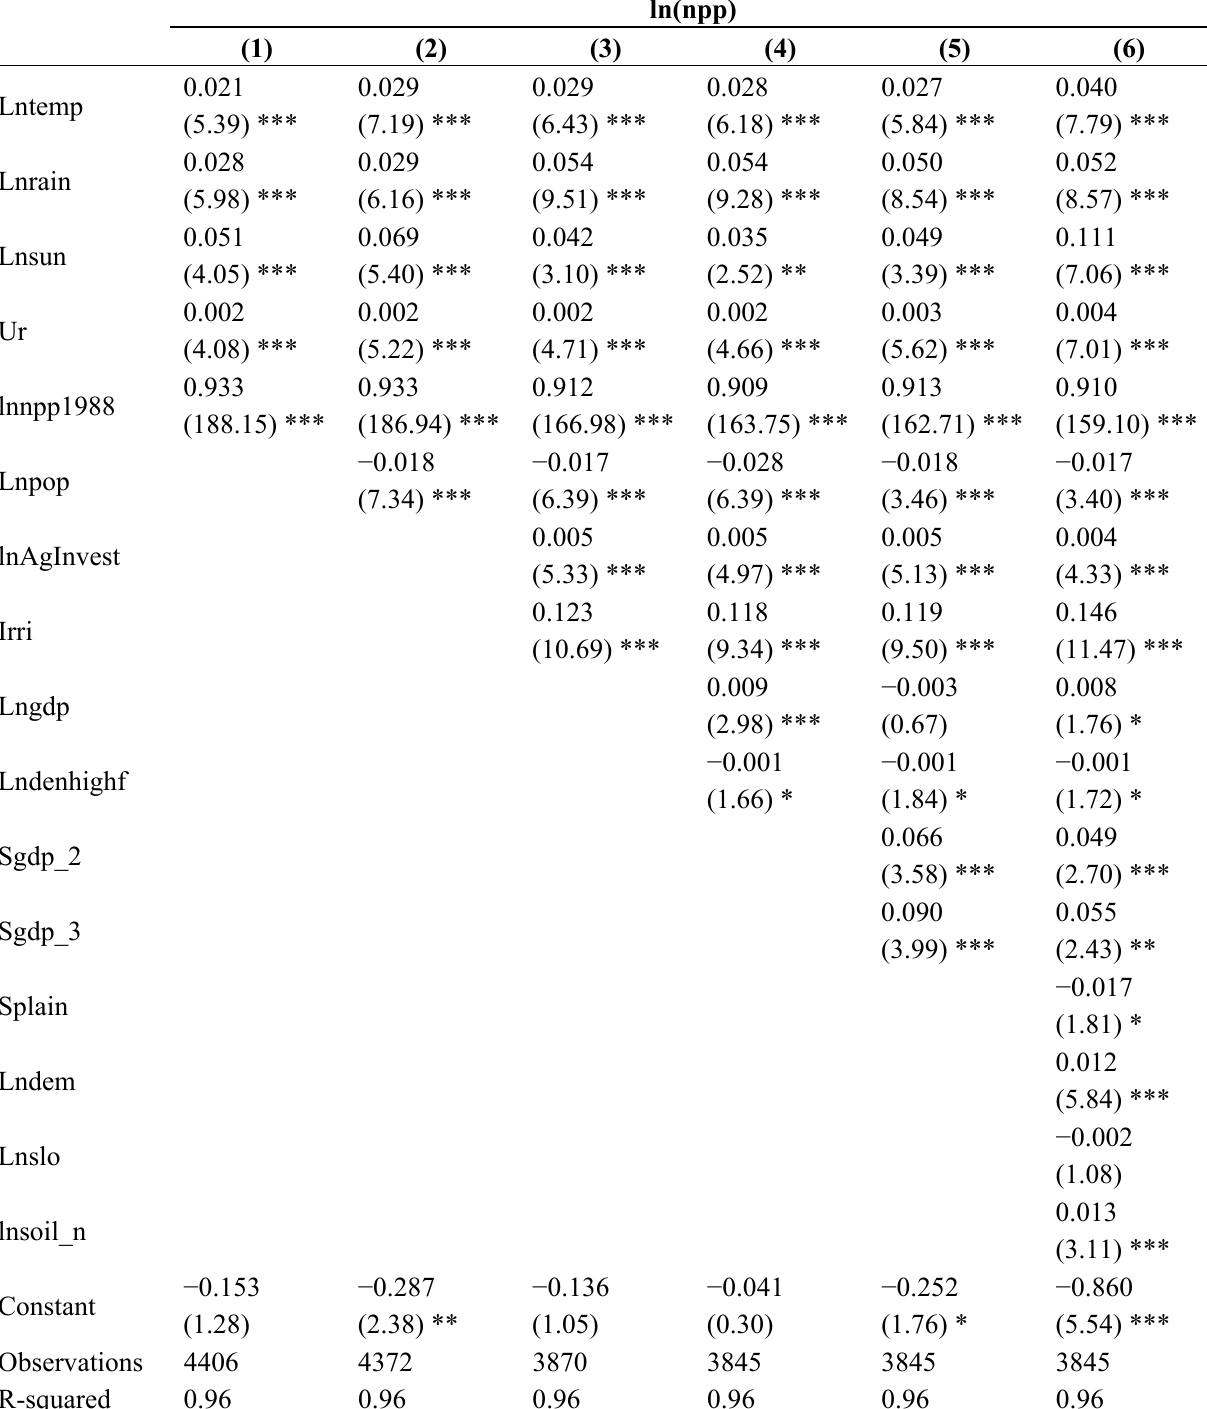
Table 2. Results from the OLS model of carbon bio-sequestration change in